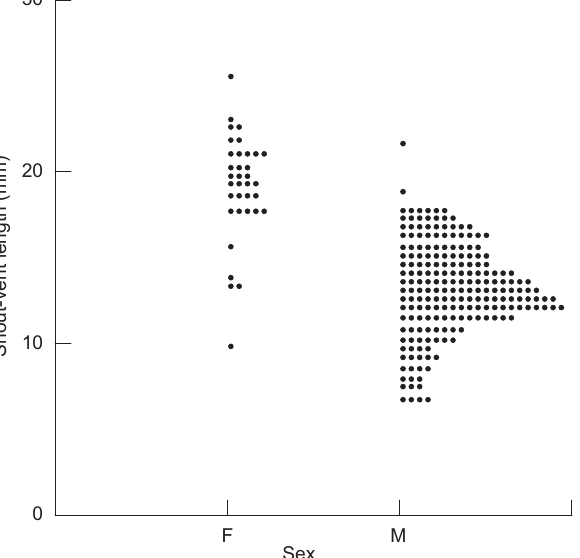
Figure 3. Body size distribution (snout-vent length, in mm) of males (M) and females (F) of I. parva (N = 220) in Santuário Ecológico da Serra da